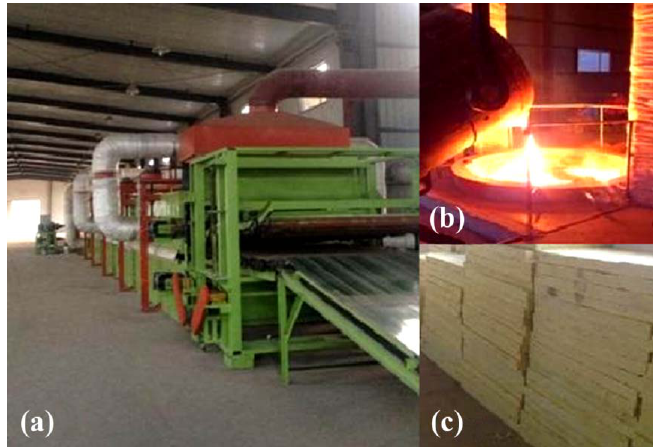
Figure 12. Equipment and insulation boards on-site in the plant. ( a ) Treatment devices; ( b ) Molten slag pouring from the tank into the modified furnace; ( c ) Slag wool insulation board product.